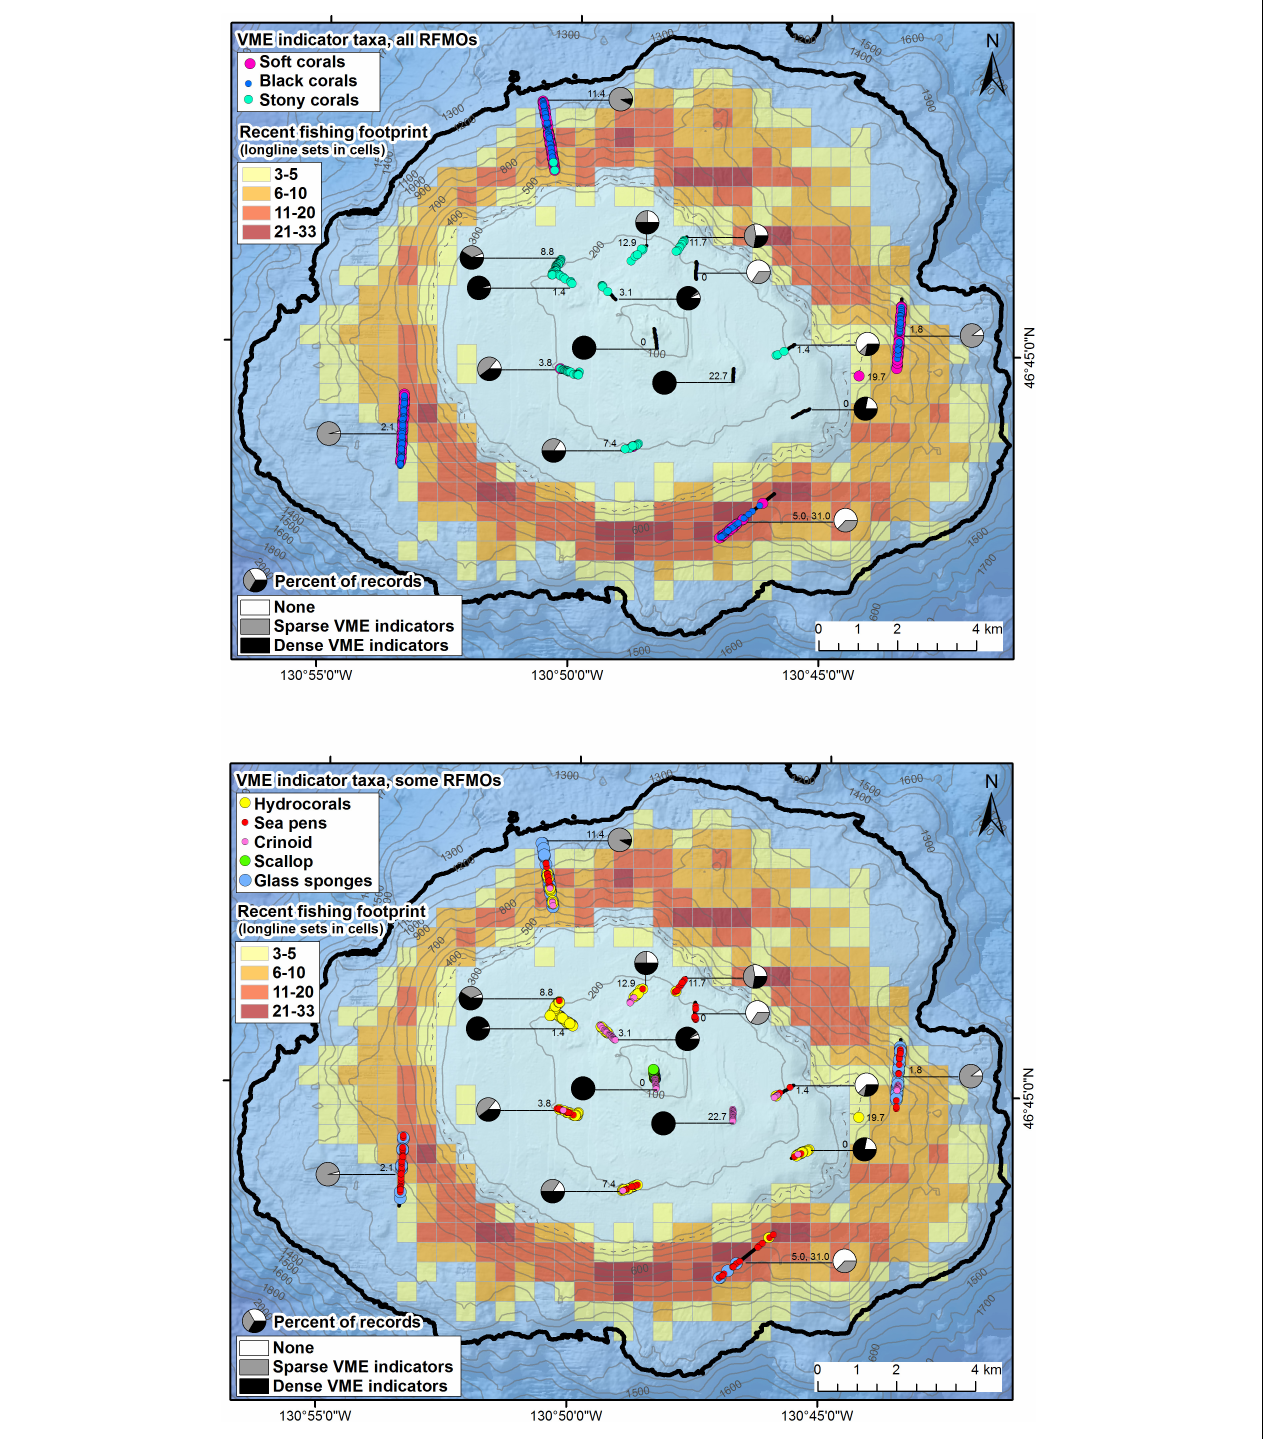
FIGURE 5 | Maps showing the densities and distributions of vulnerable marine ecosystem (VME) indicators, the recent longline fishing footprint and effort (1996–2017), and density of derelict fishing gear on Cobb Seamount. Pie charts show the percent of records per transect with no VME indicators (0 m − 2 ), sparse VME indicators ( > 0 and < 1 m − 2 ), and dense VME indicators ( ≥ 1 m − 2 ). The distributions of VME indicators are shown for taxa recognized by (A) all regional fisheries management organizations (RFMOs) and (B) those only recognized by some (not the North Pacific Fisheries Commission). The colored grid cells (500 m by 500 m) indicate the number of longline sets transecting each cell (cells with < 3 vessel removed to comply with “three-party rule”). The number adjacent to the transect is the density (km − 1 ) of derelict fishing gear observed (DFG; AUV 5 includes a second number, the density of drag mark incidents). Contour lines, 100 m depth intervals (350 and 1200 m in gray dashed and black bold,